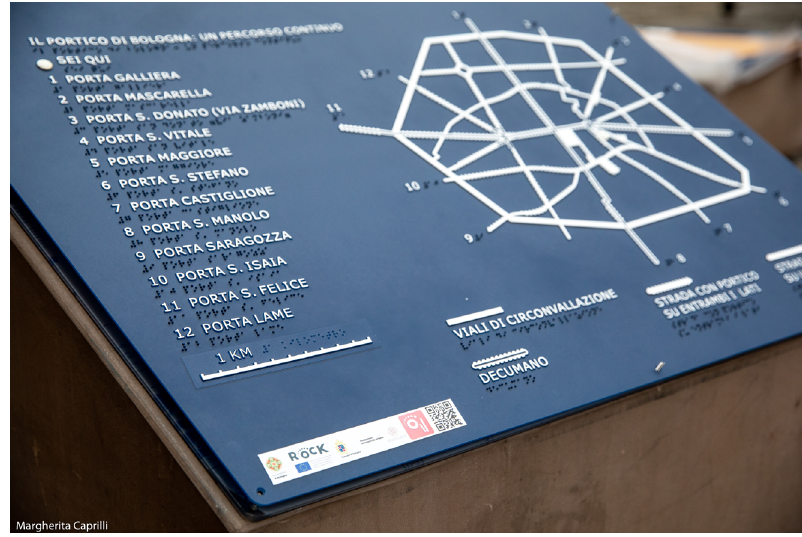
The installation of the monumental tactile map U-AREA FOR ALL - ROCK BOLOGNA project. Credits: Margherita Caprilli.